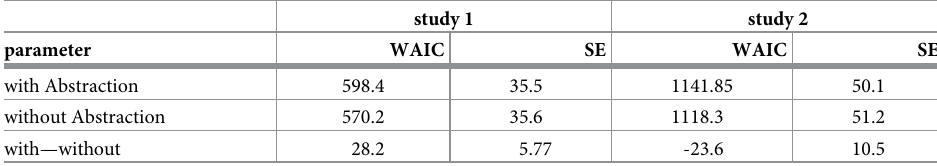
Table 1. WAIC model comparison: Level of